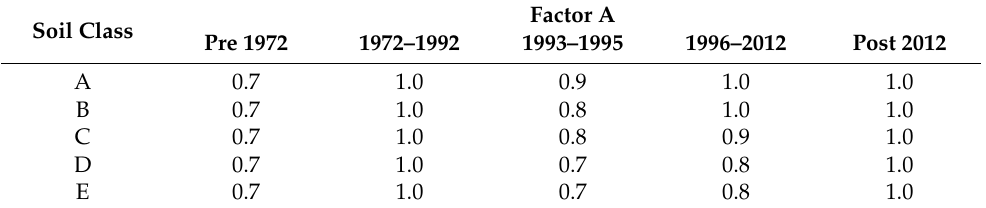
Table 1. Factor A according to building’s ground type and year of construction.